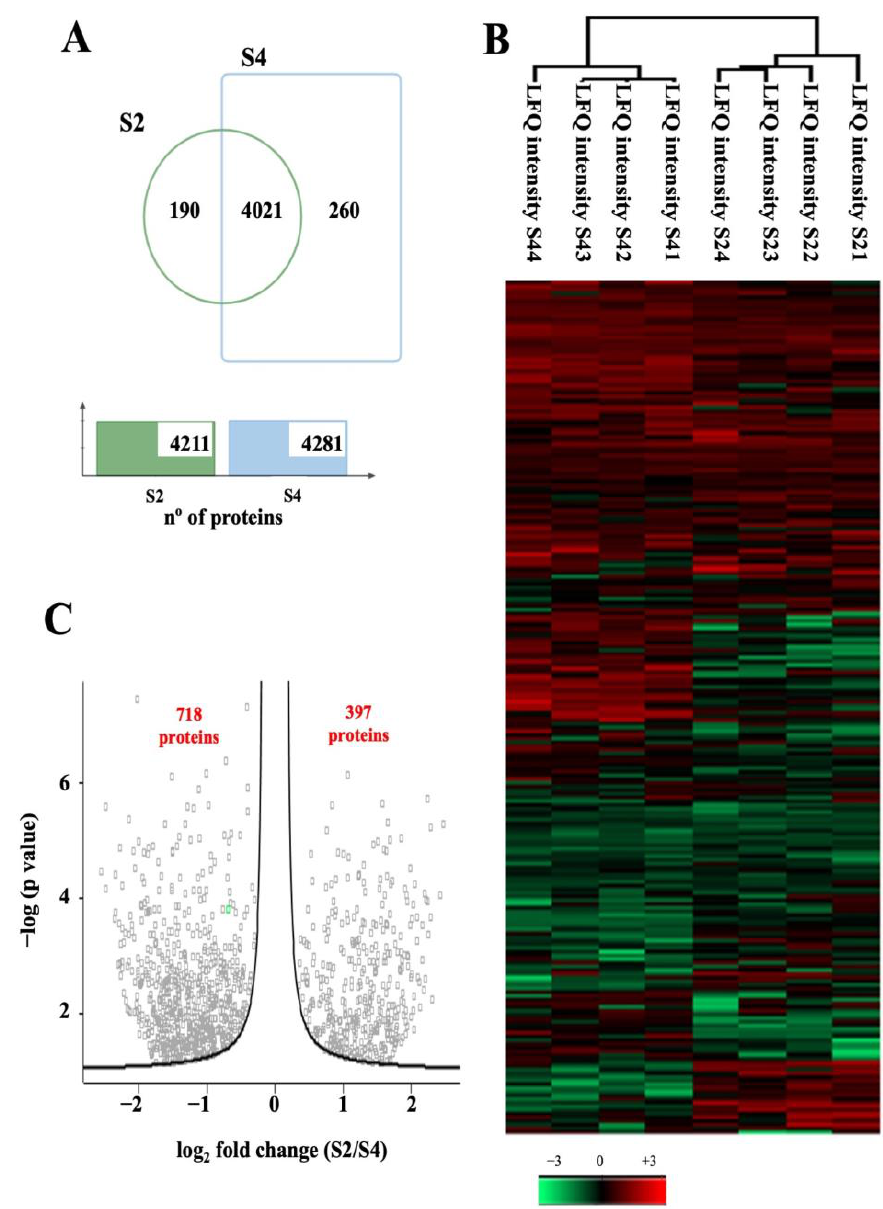
Figure 2. Proteomic analysis of protein persulfidation in response to light conditions. ( A ) Venn diagram showing the intersection of the persulfidated proteins identified in the sample sets collected in the dark (S2) and light (S4) photoperiod. ( B ) Hierarchical clustering of persulfidated proteins in dark-period collected samples (S2) and light-period collected samples (S4). ( C ) Volcano plot illustrating significantly differentially abundant proteins. The – log 10 ( p value) is plotted as the log 2 of the fold change between dark-period collected samples (S2) and light-period collected samples (S4).